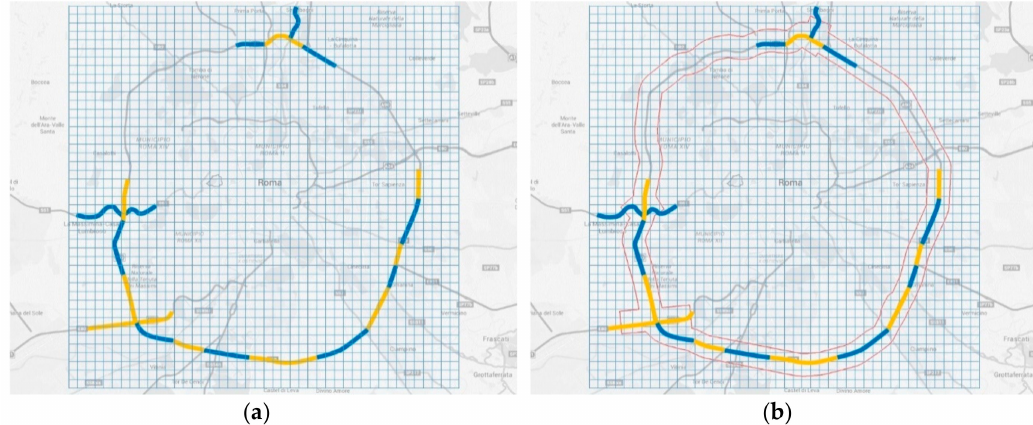
Figure 5. Basic noise maps preparation: generate a unique grid for the whole pilot area ( a ) and prepare a unique calculation area ( b ).